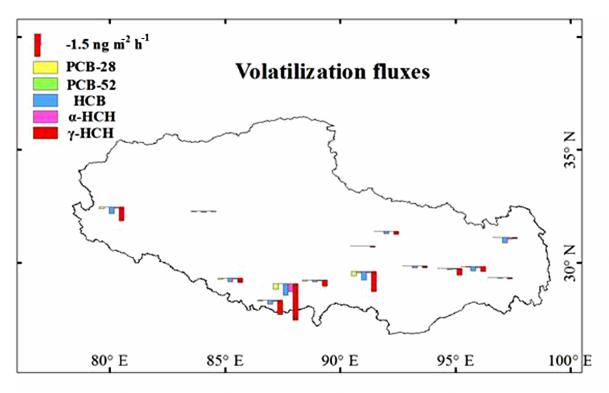
Figure 4. The geographical distribution of the net volatilization fluxes of PCB-28, PCB-52, HCB, α -HCH, and γ -HCH across the